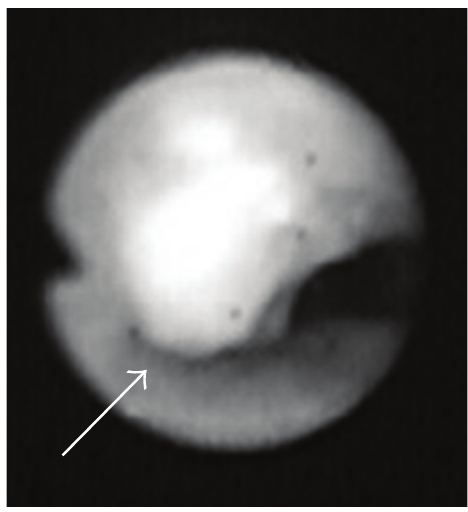
Figure 3: Bronchoscopy. Bronchoscopy shows narrowing of the trachea by a pulsatile compression on the anterior tracheal wall (white arrow).